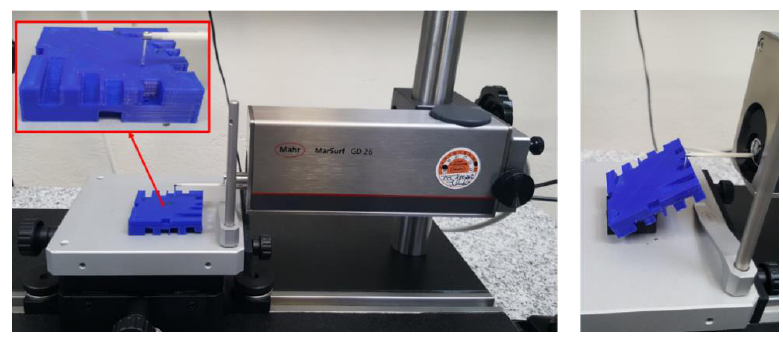
Figure 4. Stylus profilometer MarSurf GD 26.